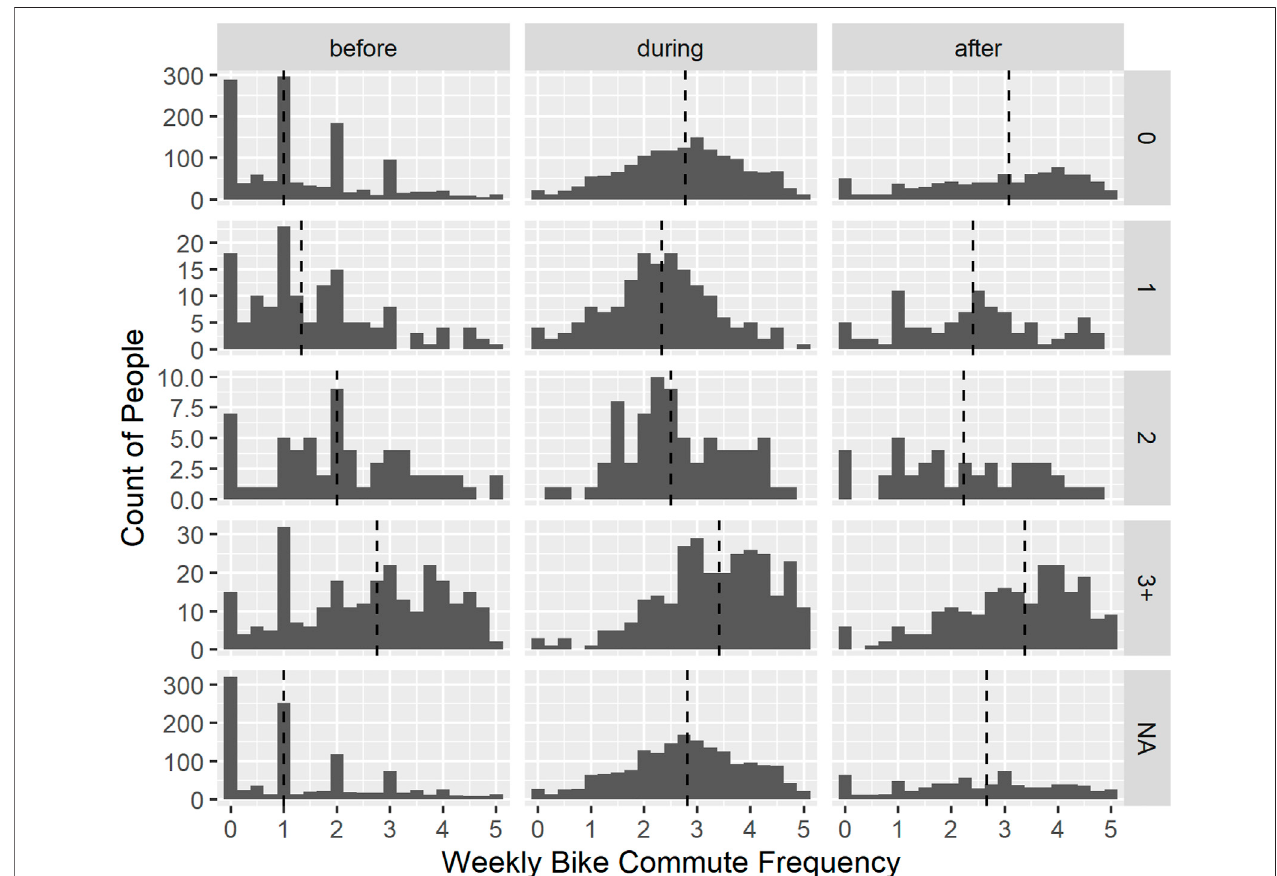
FIGURE 4 | Histograms of person-level average weekly morning bike commutes by project phase (row panels) by self-reported bike commute frequency (column panels) before participation. Dashed vertical line is the group mean.